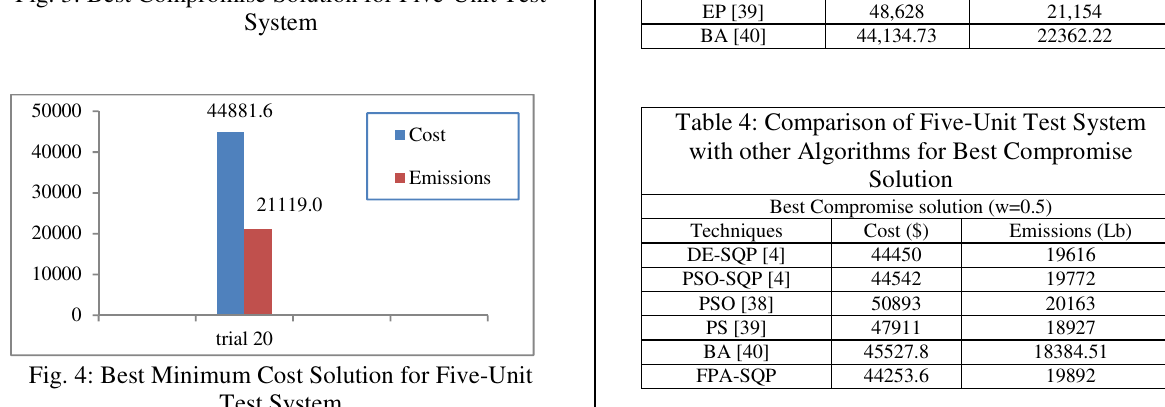
Fig. 3: Best Compromise Solution for Five-Unit Test System